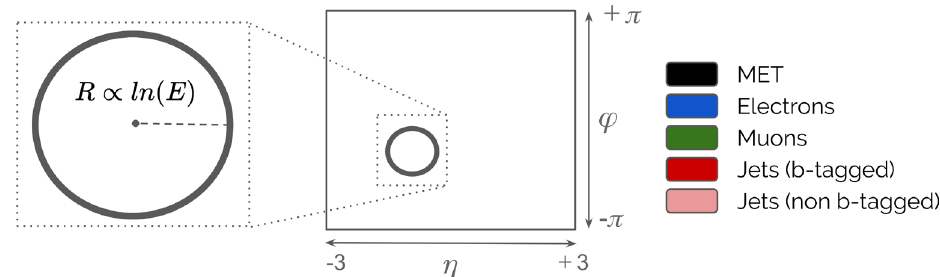
Figure 1. Particle collisions represented as an image. Particles are represented as circumferences with radius proportional to the logarithm of their energy. The horizontal position of the particles corresponds to the pseudorapidity η within the range [ 3 , 3]. The vertical position shows the azimuthal angle ϕ − π, π ]. within the range [ −